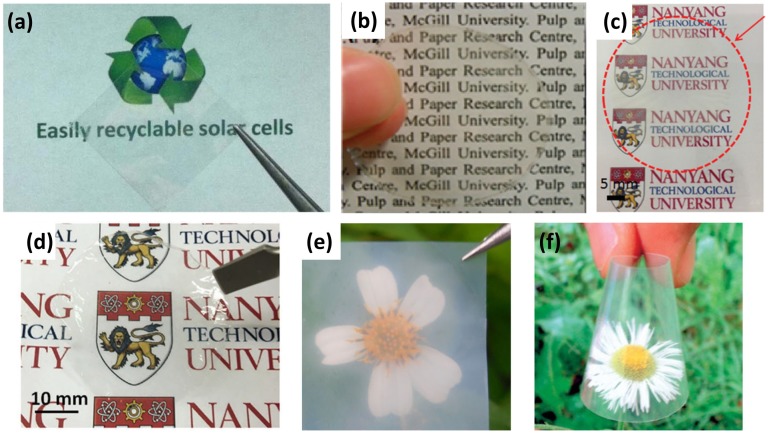
Various transparent papers made of different cellulose materials. (a) Transparent nanocomposite paper prepared by using NCCs and glycerol [31]. Reproduced with the permission of [31]. Copyright 2013 Nature Publishing. (b) Transparent nanopaper prepared by using NCCs [32]. Reproduced with the permission of [32]. Copyright 2012 American Chemical Society. (c) Transparent nanopaper obtained from NFCs by vacuum filtration [41]. Reproduced with the permission of [41]. Copyright 2015 Wiley-VCH. (d) Transparent nanopaper made of TEMPO-oxidized NFCs by vacuum filtration [42]. Reproduced with the permission of [42]. Copyright 2016 Wiley-VCH. (e) Transparent nanopaper made of BC sheet [22]. Reproduced with the permission of [22]. Copyright 2016 Springer Publishing. (f) Transparent nanocomposite paper prepared by using BC sheet with acrylic resin [23]. Reproduced with the permission of [23]. Copyright 2005 Wiley-VCH.